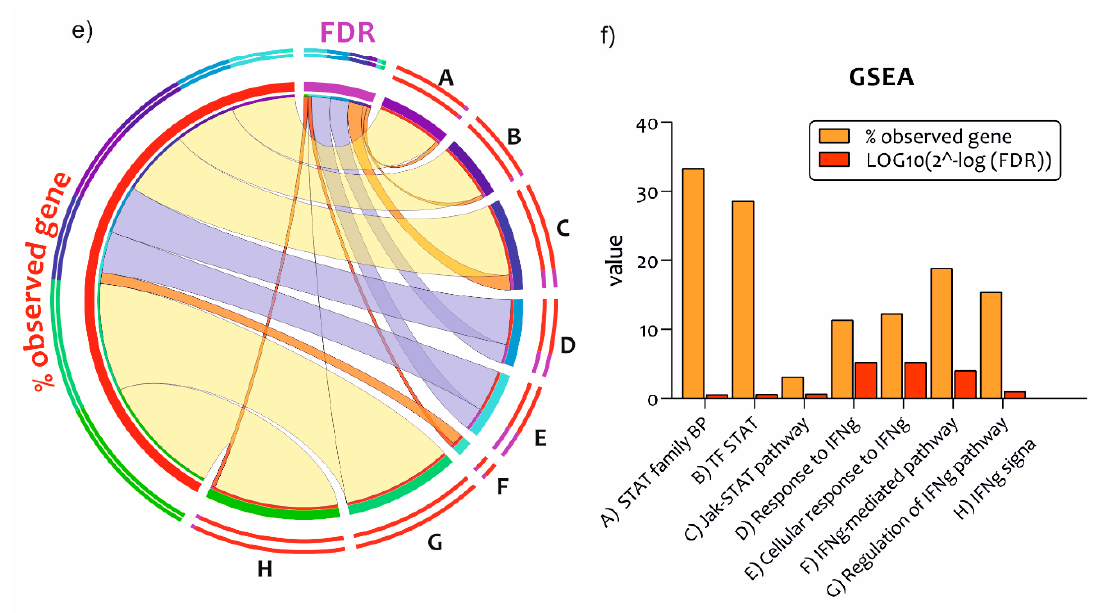
Figure 4. IFNG genes pathways expression levels in PB CD34 + Cells of PMF patients. JAK2 is necessary and su ffi cient for IFNG-induced transcription of genes involved in immuno-response against antigens self / non-self. In our analysis, we showed that IFNG gene expression levels were significantly downregulated in PB CD34 + cells of PMF patients wild-type for JAK2 V617F mutation compared to healthy controls subjects ( a ), but not compared to JAK2 V617F mutated patients. Similar trends were observed for IRF1 ( b ) and IFNGR2 ( d ). The IFNGR1 modulation was an exception ( c ). GSEA of IFNG and STAT pathways. The data visualization was obtained by tool CIRCOS. The ribbons are expressed by weighted percentage (Q1 = red; Q2 = orange; Q3 = yellow; Q4 = purple). For Q1 and Q2 we used a transparency of 4 and no stroke ( e ). GSEA of IFNG and STAT1 pathways are expressed in a bar chart ( f ). Data are expressed as z-score intensity expression levels and presented as vertical scatter dot plots. p values <0.05 were considered to be statistically significant (* p < 0.05; ** p < 0.005; *** p < 0.0005; **** p < 0.00005).